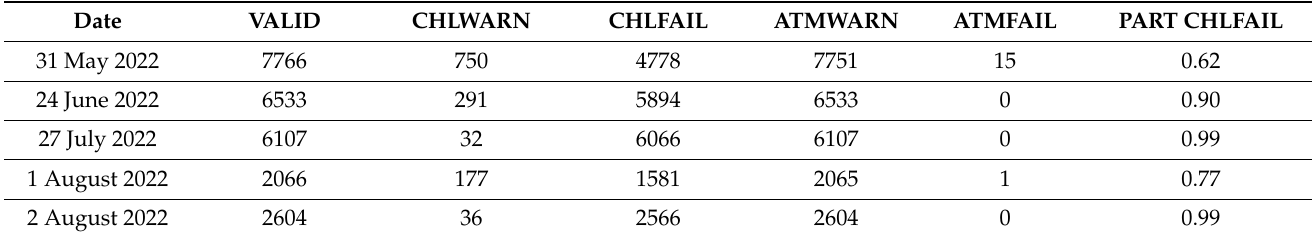
Table 4. The proportion of pixels with CHLFAIL flags based on ac-2 results for S-3B images.